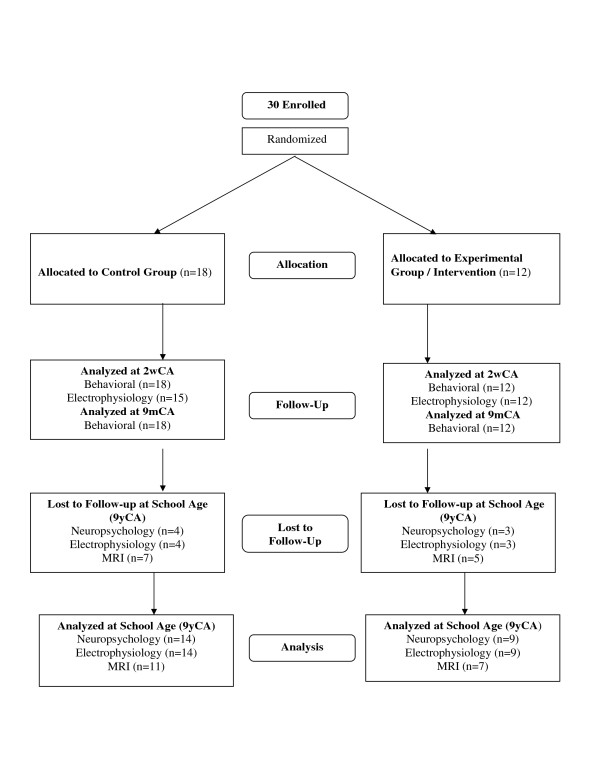
Consort flow chart.